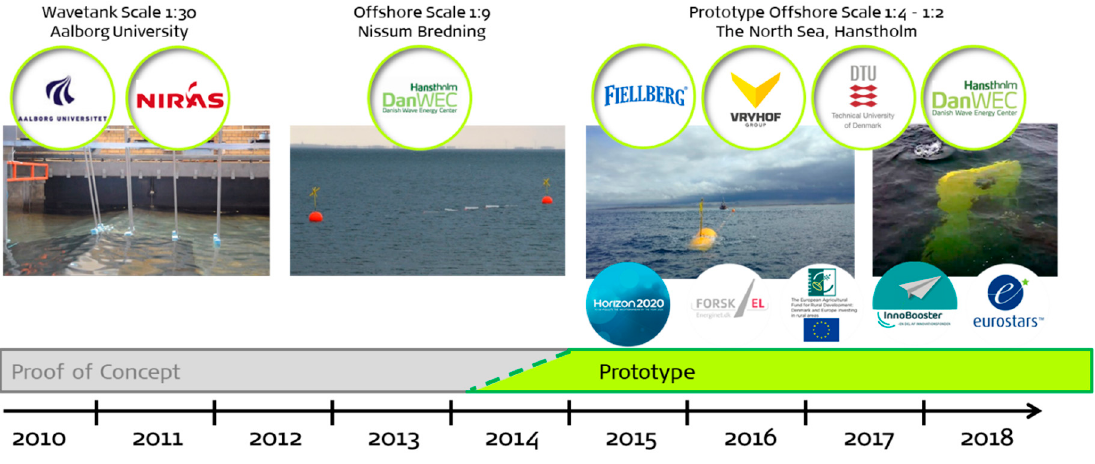
Figure 2. Technology